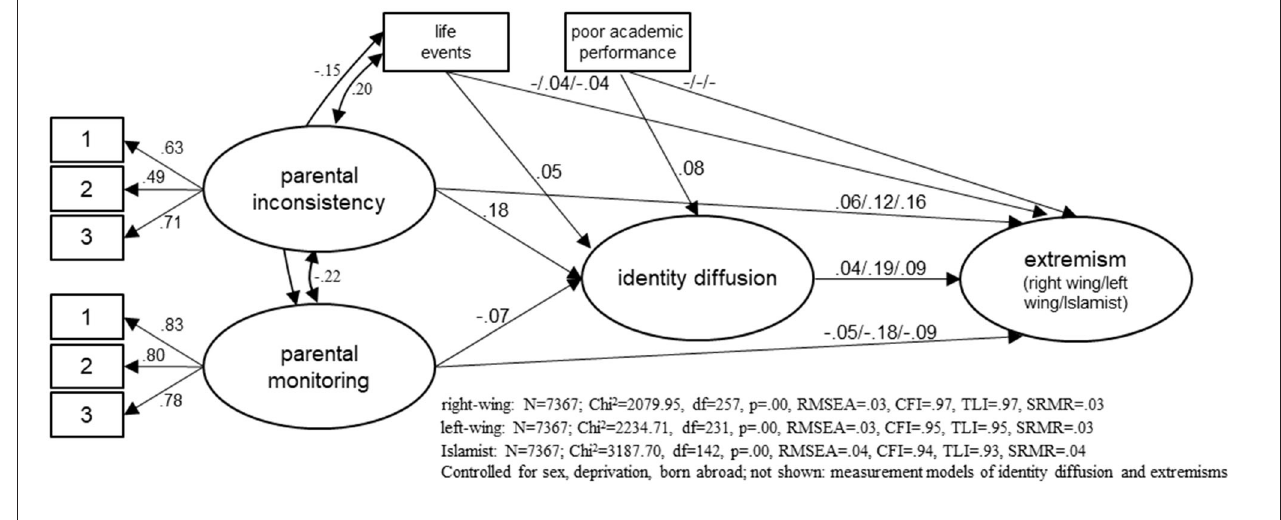
FIGURE 2 | Model to explain extremist attitudes by identity diffusion and other independent variables. Displayed: standardized coefficients; estimation procedure: Maximum Likelihood; left coefficients: model for right-wing extremism/medium coefficients: left-wing extremism/right coefficients: Islamist extremism; all coefficients significant at p < 0.05; “–” coefficient not significant at p < 0.05.